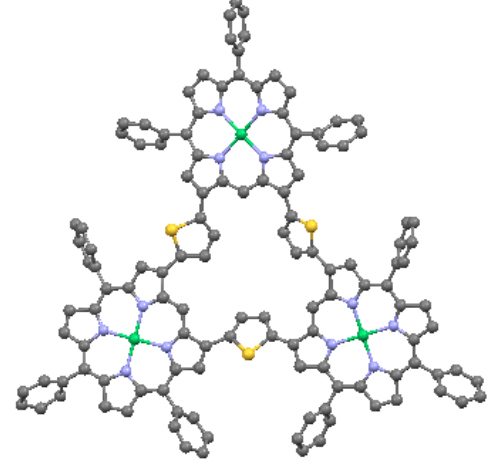
Figure 22. Thienylene-bridged triangular Ni-porphyrin tetramer, from data in [7,58]. Green = Ni, yellow = S.